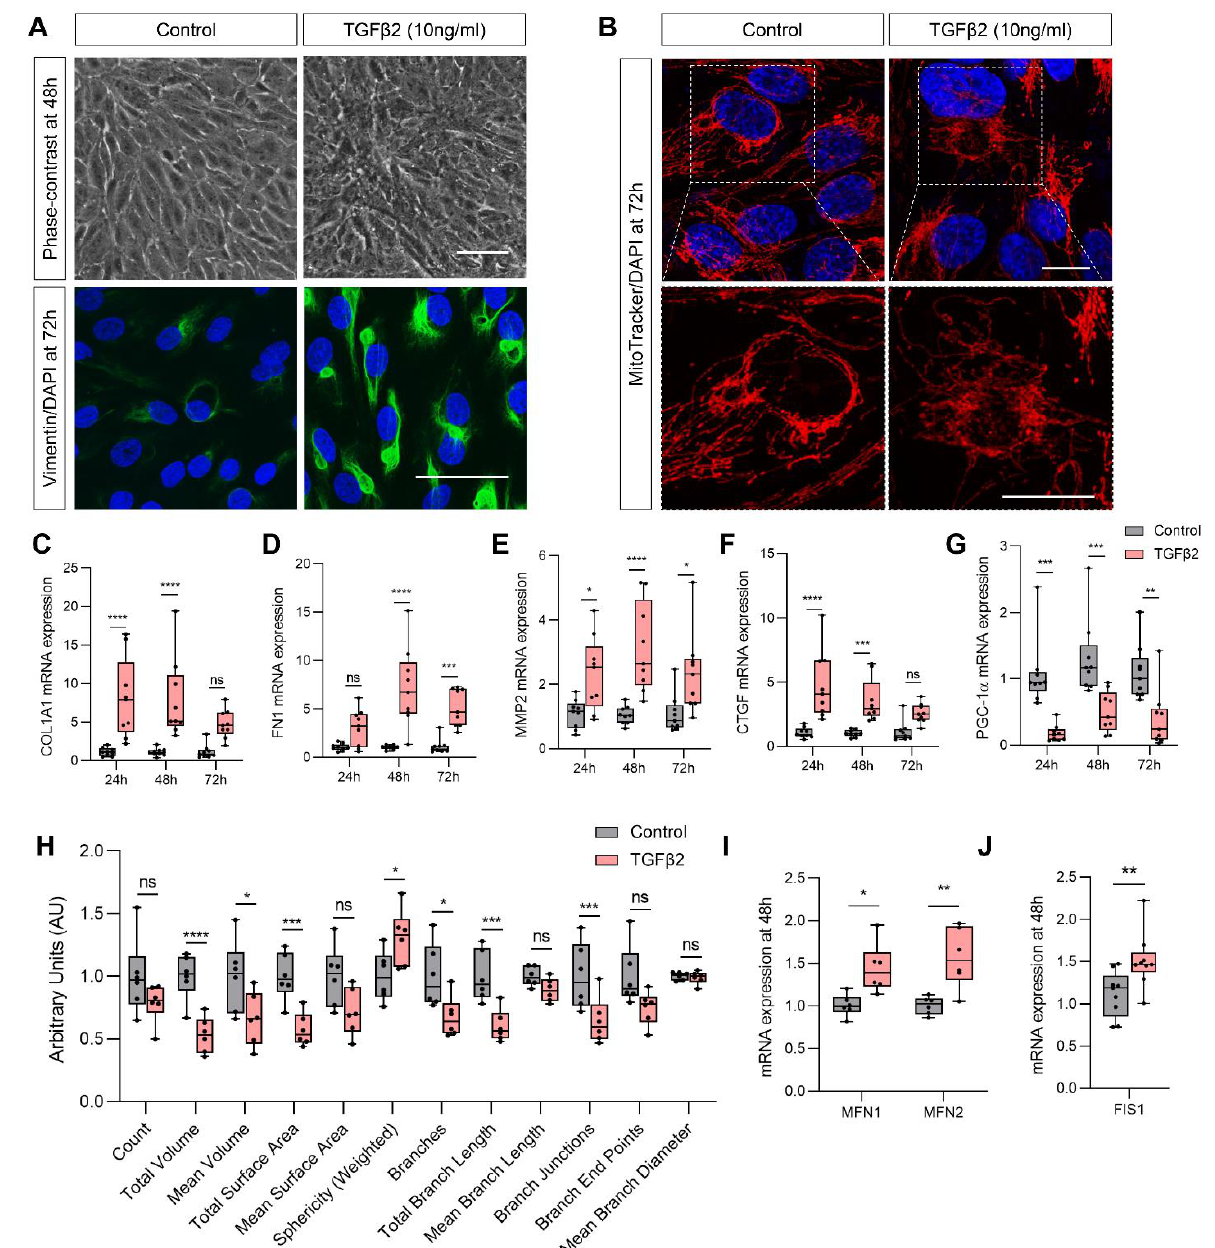
Figure 1. TGF β 2-induced epithelial-mesenchymal transition (EMT) is accompanied by mitochondrial dysfunction. ARPE-19 cells were treated with TGF β 2 for up to 72 h. ( A ) Representative phase-contrast images depicting cellular morphology at 48 h ( n = 3, scale bar is 50 µ m) and representative immunofluorescence images of the mesenchymal marker, vimentin (green) and DAPI (nuclei, blue) at 72 h ( n = 3, scale bar is 50 µ m). ( B ) Representative images showing mitochondrial morphology using confocal microscopy imaging of MitoTracker Orange (red) and DAPI (nuclei, blue) at 72 h ( n = 3, scale bar is 20 µ m) for control and TGF β 2-treated cells and corresponding magnified views of selected areas (scale bar is 20 µ m). Quantification of mesenchymal genes ( C ) COL1A1 , ( D ) FN1 , ( E ) MMP2 , ( F ) CTGF and ( G ) PGC-1 α by qPCR at 24, 48 and 72 h with or without TGF β 2 treatment ( n = 9, two-way ANOVA with Sidak’s post-hoc analysis). ( H ) Confocal images were analyzed by automated processing to quantify mitochondrial shape and network parameters ( n = 6, unpaired t -test). Quantification of mitochondrial fusion gene expression following treatment with or without TGF β 2 at 48 h for fusion genes ( I ) MFN1 and MFN2 ( n = 6, two-way ANOVA with Sidak’s post-hoc analysis) and the mitochondrial fission gene ( J ) FIS1 ( n = 9, unpaired t -test). Error bars are means ± SEM. * p ≤ 0.05; ** p ≤ 0.01; *** p ≤ 0.001; **** p ≤ 0.0001; ns, not significant.